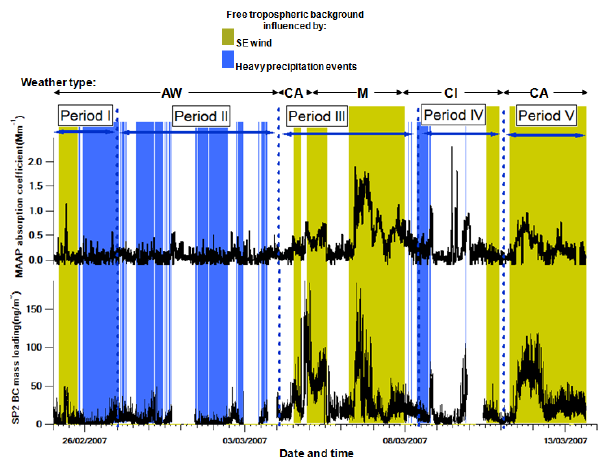
Fig. 2. Fig. 2. Time series of total rBC mass loading from the SP2 and ab- sorption coefficient measured by the Multi-Angle Absorption Pho- tometer (MAAP) for the entire experiment. The five synoptic pe- riods classified by back trajectory analysis (Fig. 1, A1–A5) are separated by dotted lines. The top text line indicates the recog- nized weather types as detailed in Table 1, with arrows denoting respective periods. Particularly, the time periods when the dom- inant horizontal wind direction is southeast (SE) are coloured as yellow columns; the dark blue columns mark the periods of heavy precipitation (heavy snow, precipitation particle concentration over 200L − 1 ) as recorded by a present weather sensor.